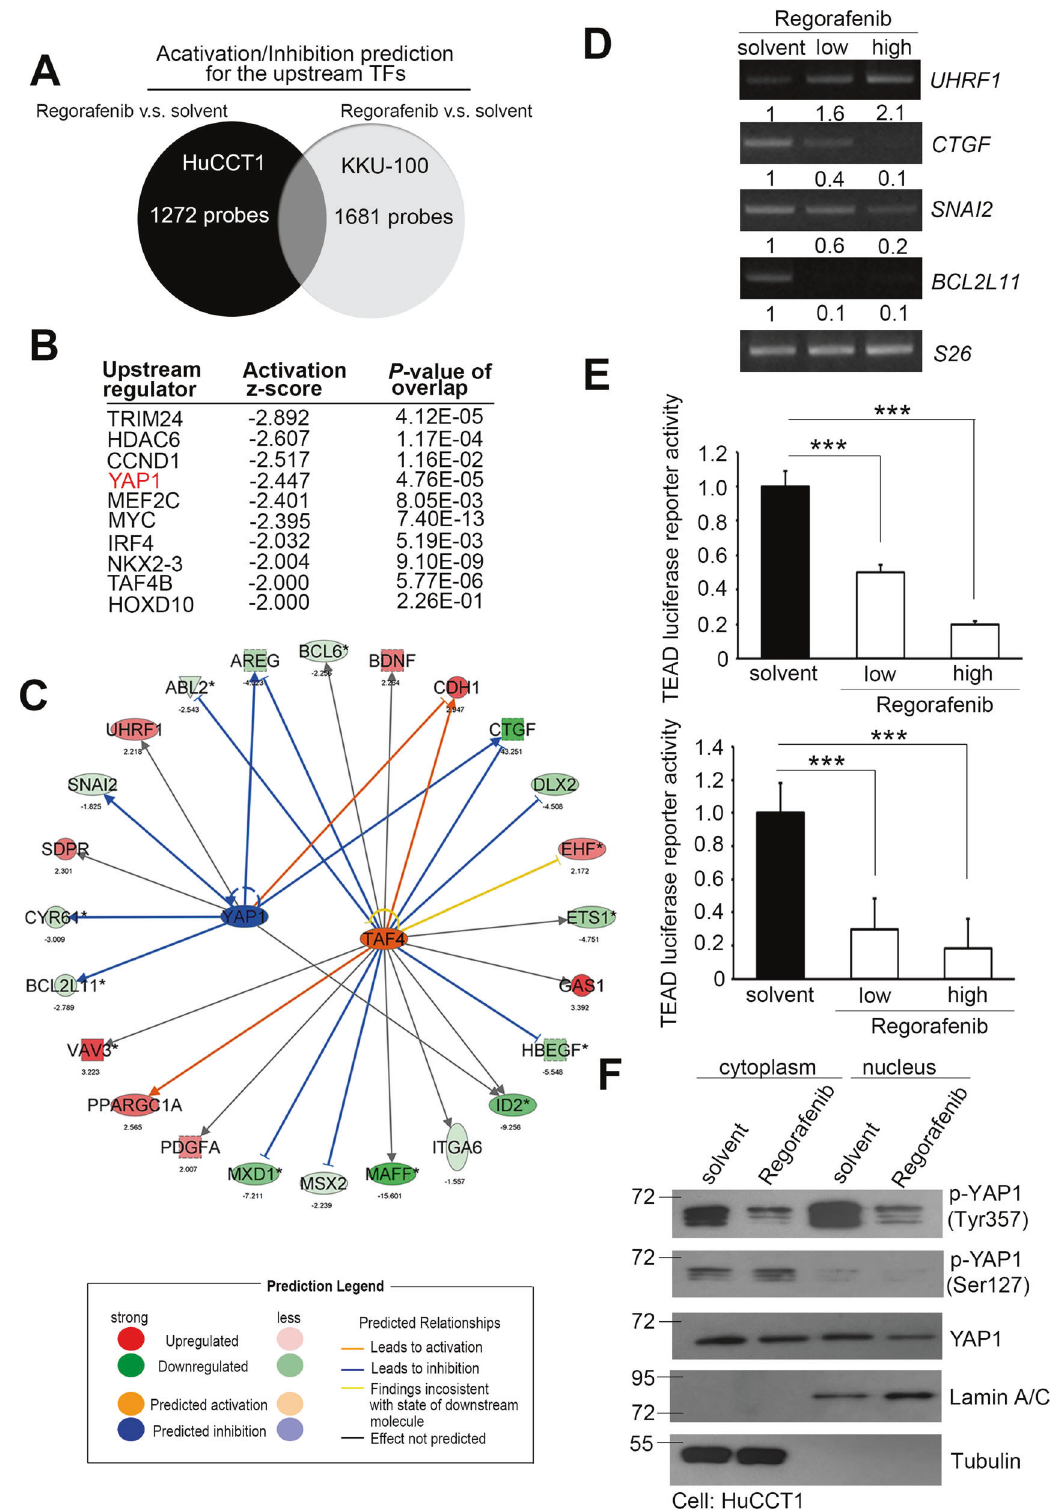
Fig. 1 Regorafenib suppresses YAP1 signaling pathway in CCA cells. A Venn diagram of the potential transcription factors in HuCCT1 and KKU-100 cells of the regorafenib treatment group and solvent control group. B Ranking of the candidate upstream regulators of transcription inhibition from regorafenib treatment and solvent control groups predicted by Ingenuity pathway analysis with a 1.5-fold change cutoff. C Core analysis of the YAP1 and TAF4 signatures in regorafenib-treated and control HuCCT1 cells. D RT-PCR analysis of YAP1 downstream targets and S26 mRNA expression in regorafenib-treated HuCCT1 cells. E Luciferase reporter activity of TEAD in HuCCT1 and SNU-1079 cells treated with or without regorafenib. F Western blots showing YAP1 and p-YAP1 (Ser127 and Tyr357) protein levels after treatment of HuCCT1 cells with regorafenib (10 μ M). Data are presented as the mean of three independent experiments ± SEM. The signi fi cance of the difference was determined using a nonparametric Mann – Whitney U -test. * p < 0.05, ** p < 0.01, *** p < 0.001. Cell Death and Disease (2022)